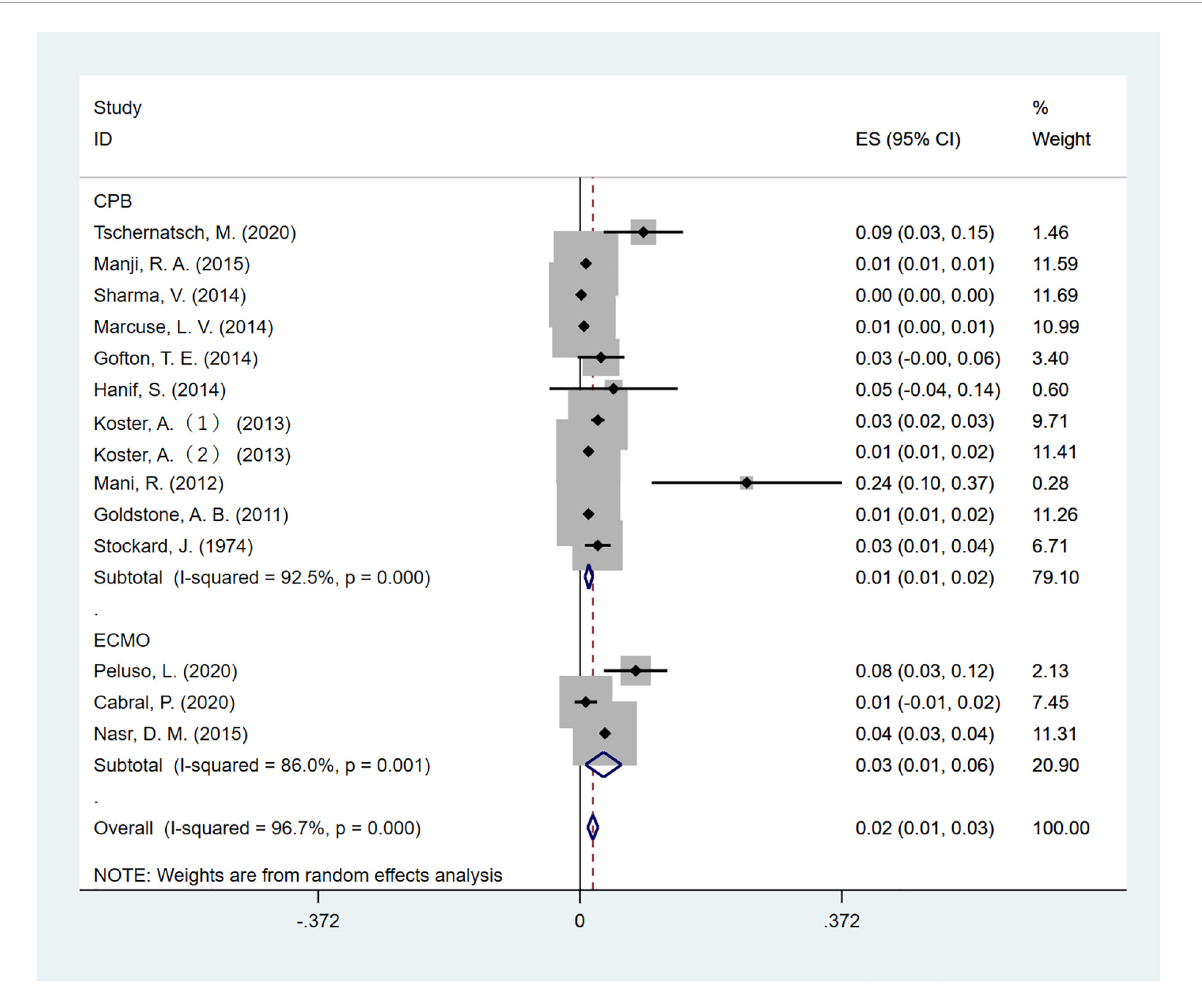
FIGURE2 The forest plot shows the pooled event rate with 95% CIs of all electroencephalography seizures after mechanical support in adults, the random-effects model was used.